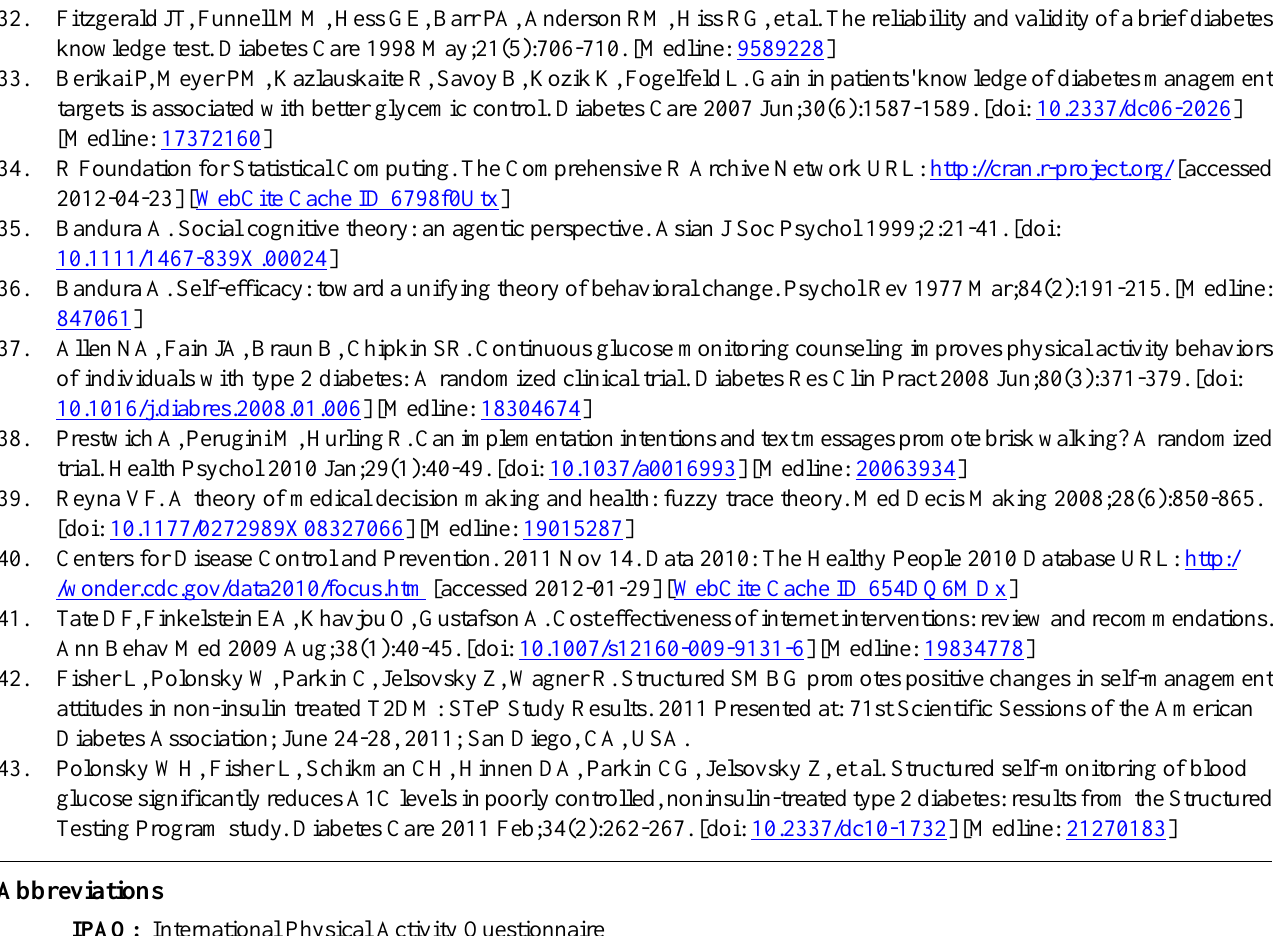
IPAQ: International Physical Activity Questionnaire T2DM: type 2 diabetes